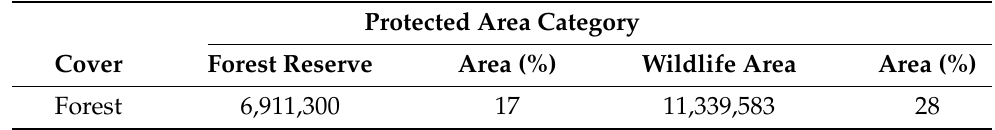
Table 9. A summary of forest extent (ha) in protected areas. Area percentage computed from a total estimated forest area (40,797,600 ha) of the classification result (Table 5).